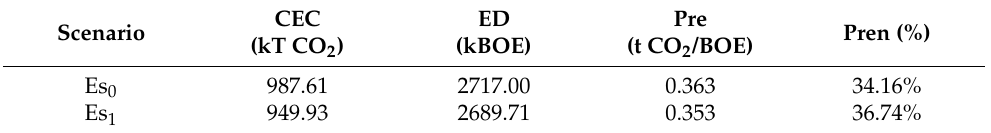
Table 24. Purity of